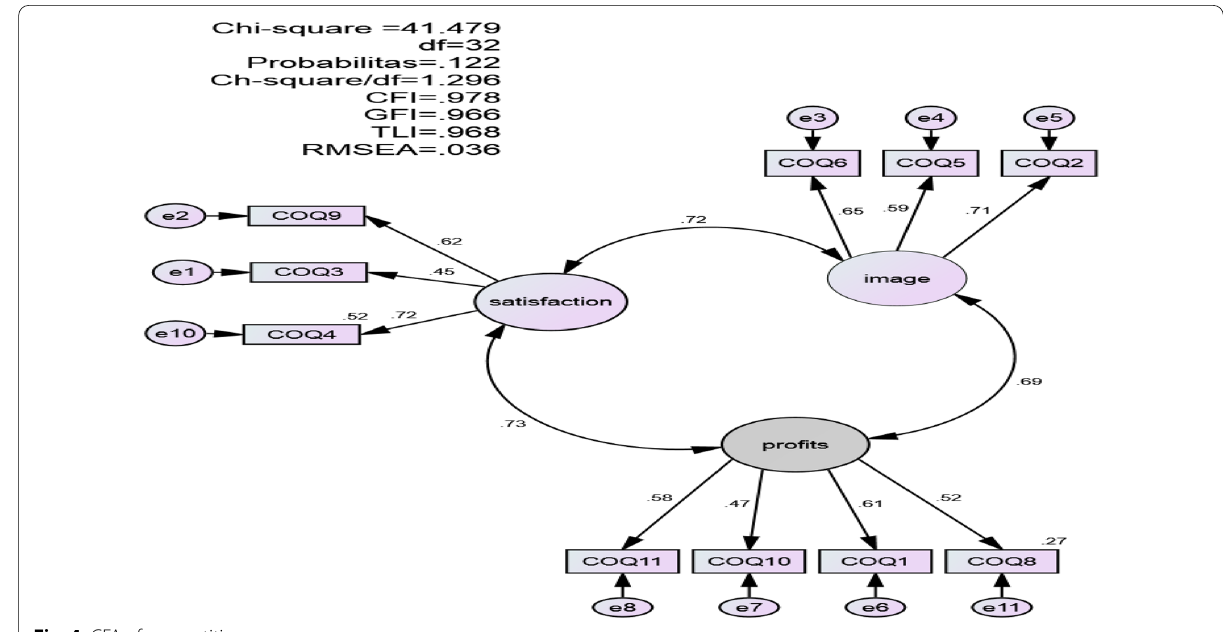
Fig. 4 CFA of competitiveness